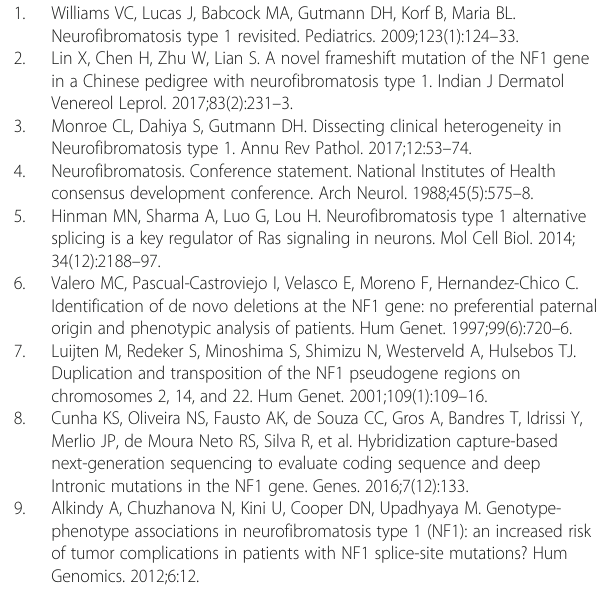
Additional file 1: Figure S1. Pedigrees of families of sporadic cases. The arrows indicate the probands in each family. The asterisks denote that peripheral blood samples of individuals had been acquired. a – e : Pedigrees of Families 6 – 10. Figure S2. Multiplex ligation-dependent probe amplification (MLPA) results using P081 and P082 probemixes for patients in Family 12. a : MLPA results using P081 for Patient 22; b : MLPA results using P081 for Patient 23; c : MLPA results using P082 for Patient 22; d : MLPA results using P082 for Patient 23. Figure S3. Amino acid sequences of neurofibromin around missense mutations. Mutation sites are highlighted. a : The amino acid G629 and surrounding sequence; b : The amino acid L1490 and surrounding sequence; c : The amino acid W1931 and surrounding sequence. Table S1. Primers used in this study. Table S2 In silico analysis of missense mutations. (PDF 781 kb)